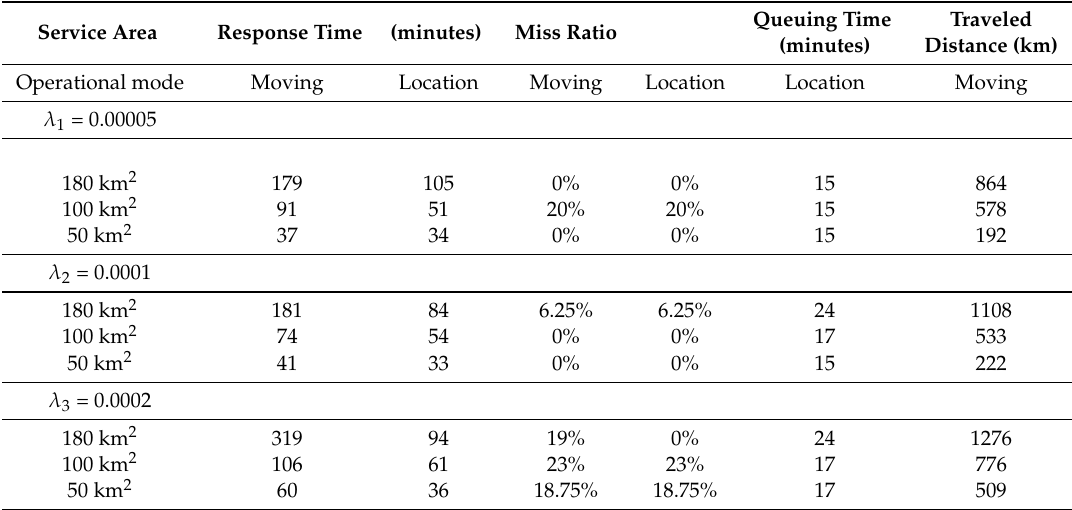
Table 5. Operational metrics for moving and temporary location operational